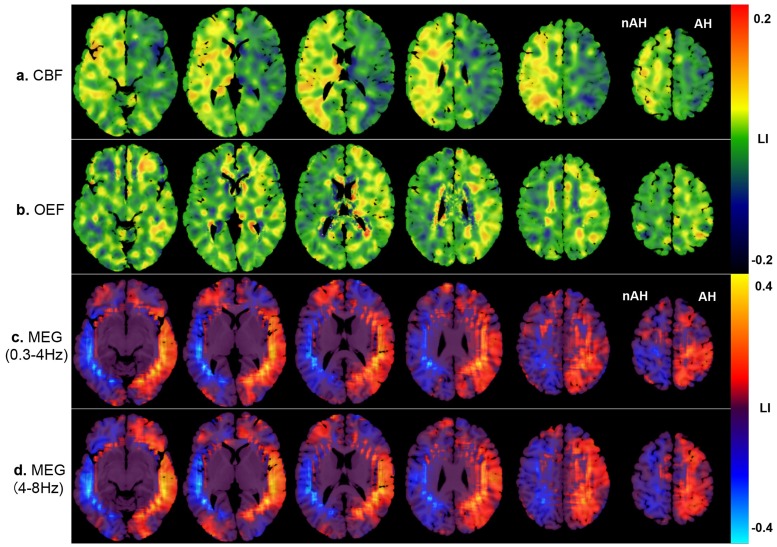
LI from the 15O-PET and MEG images of the 37 patients using SPM.These images show the LI of the 15O-PET and MEG images of the 37 patients included in the present study, showing CBF (a), OEF (b), 0.3- to 4-Hz waves (c), and 4- to 8-Hz waves (d). The averages of the LI are encoded with color (values are shown in the color bars). The images were anatomically standardized by SPM. CBF values are decreased and OEF values are increased in the affected hemisphere. Both 0.3- to 4-Hz and 4- to 8-Hz MEG waves are distributed in the affected hemisphere, predominantly from the posterior temporal to parietal regions. AH: affected hemisphere, nAH: non-affected hemisphere.